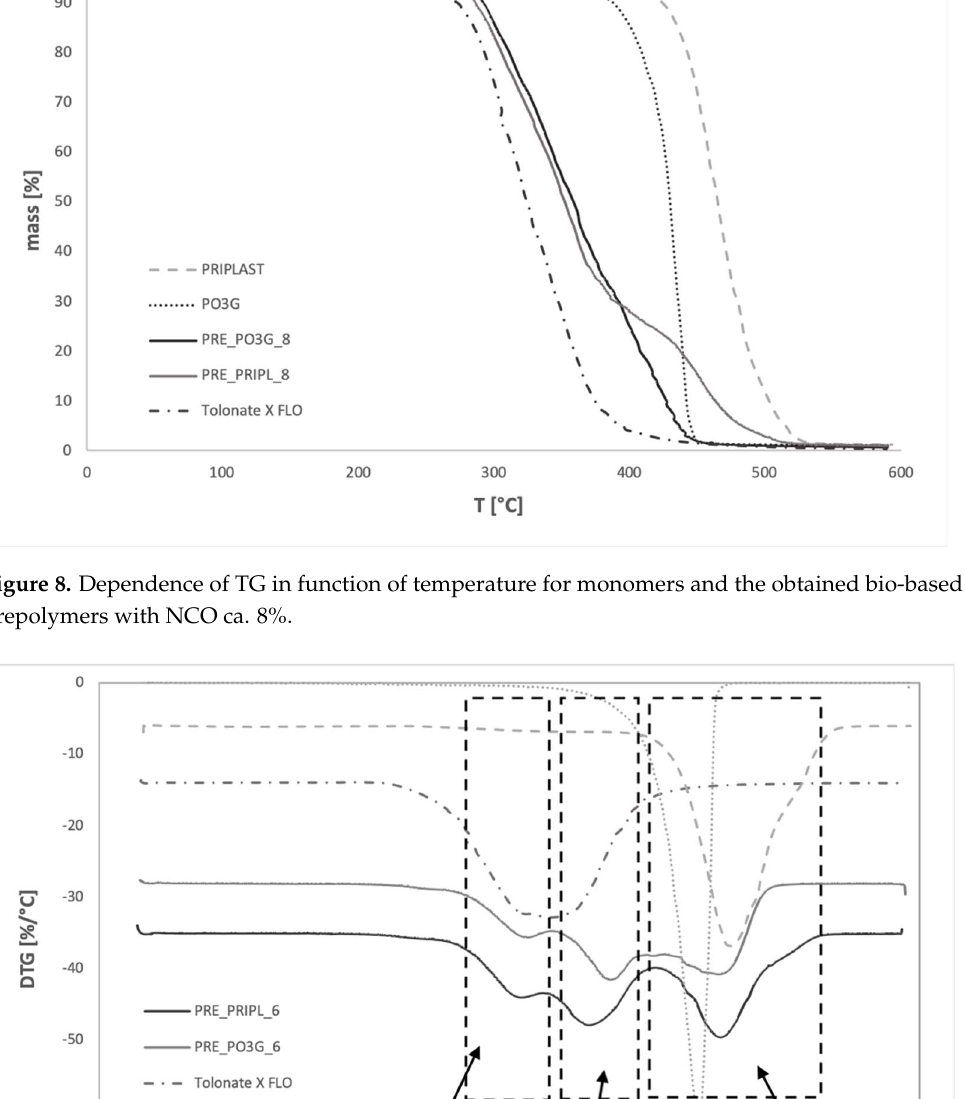
Figure 7. Dependence of TG in function of temperature for monomers and the obtained bio-based prepolymers with NCO ca. 6%.